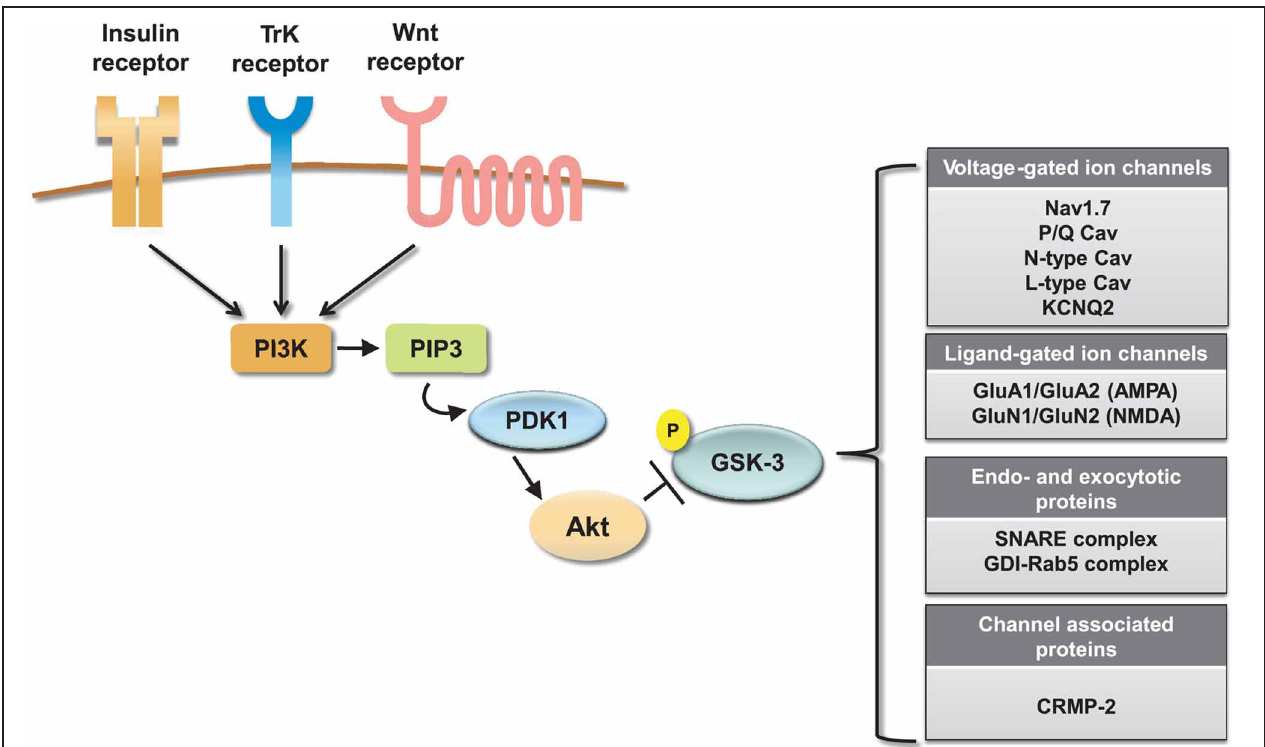
This cascade activates the major GKS-3 negative regulator, Akt. Activation of Akt results in inhibition of GSK-3 by phosphorylation at S9 (for GSK-3 β ). On the side, a summary table shows relevant ion channels, endo- and exocytotic proteins and channel associated proteins that have been identified as GSK-3 targets.